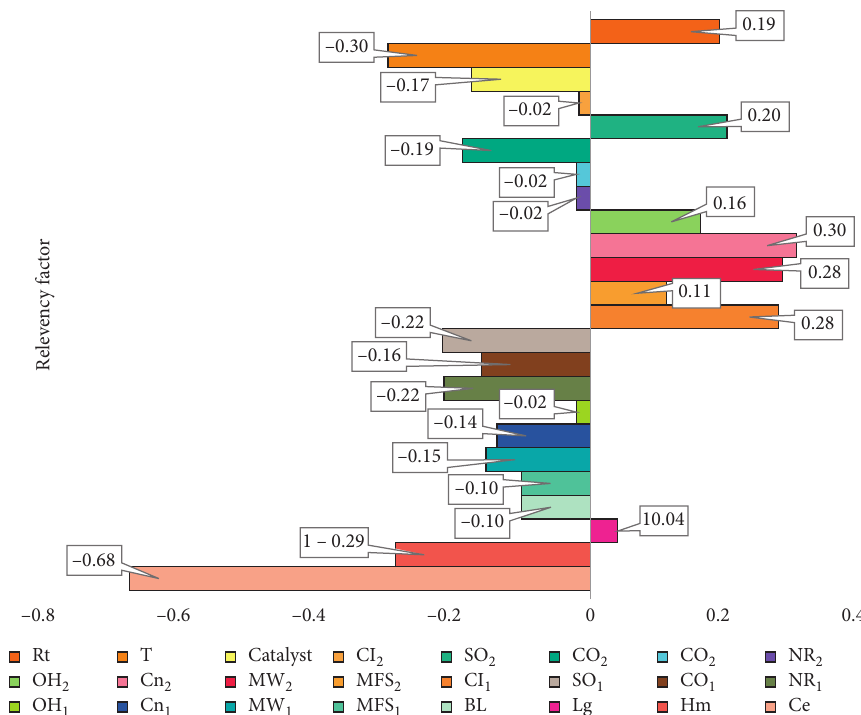
Figure 1: Sensitivity of parameters affecting the output parameter SR.